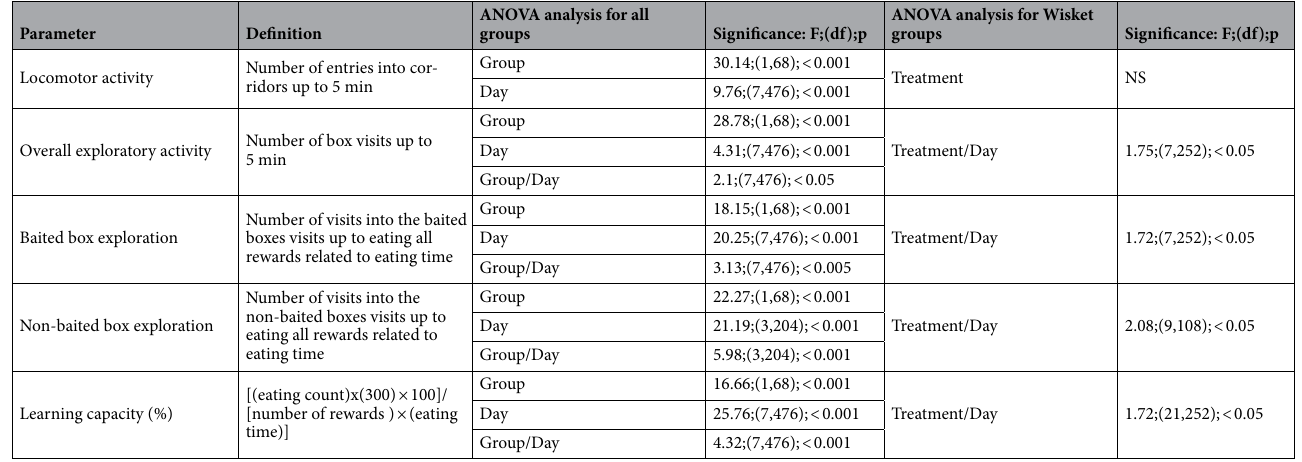
Table 1. ANOVA results for the in vivo